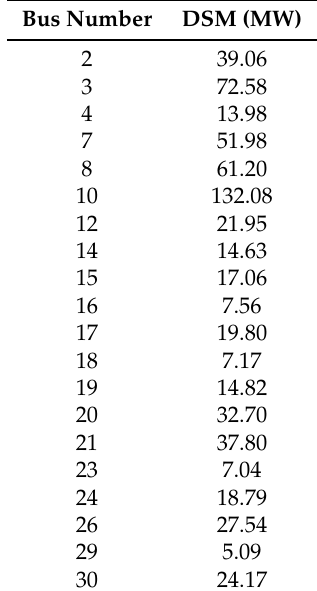
Table 2. DSM capability of load points.